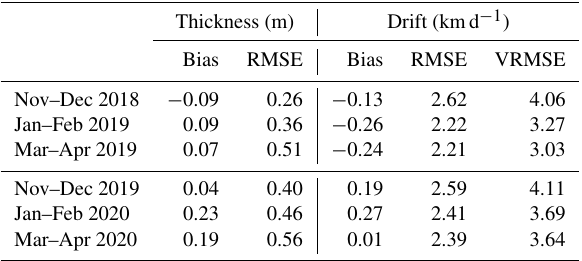
Table 2. Accuracy of the free run for the 2018–2019 and 2019–2020 winters. Thickness is evaluated against CS2-SMOS and drift against OSI SAF drift, where only observations with reported error less than 1.25kmd − 1 are considered. Results are